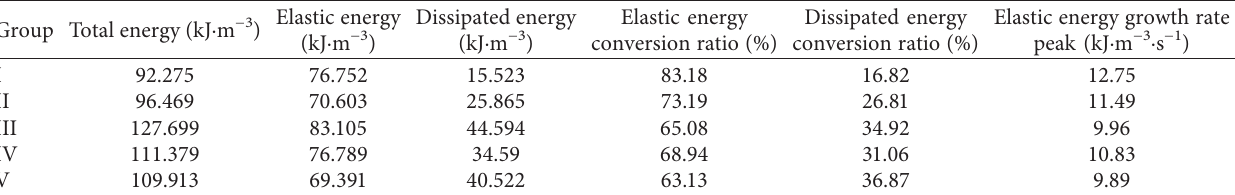
Table 2: Internal energy conversion of coal-like material sample under different borehole arrangements.